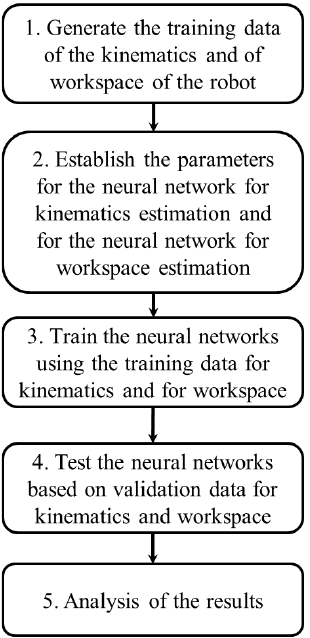
Figure 1. Representation of the problem formulation.